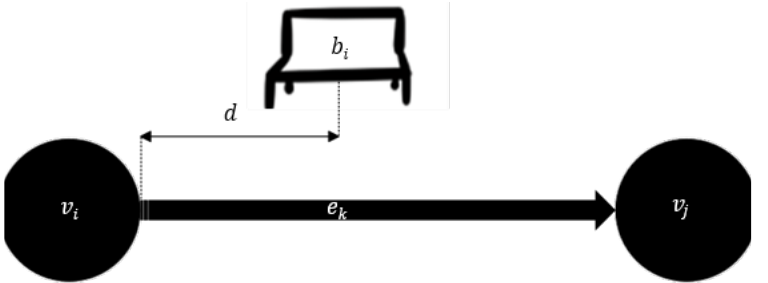
Figure 11. Mathematical representation of SAV pick-up areas placement in network.